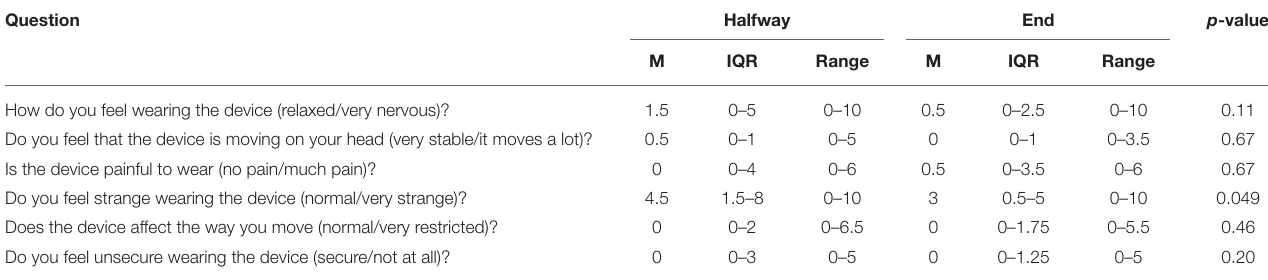
TABLE 3 | Acceptability of wearing the fNIRS system.